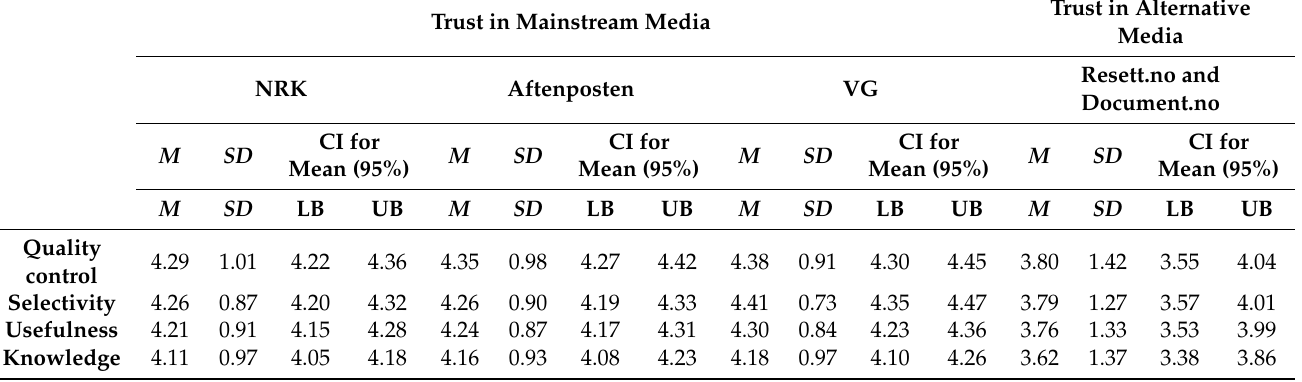
Table 3. Attitudes towards journalistic gatekeeper functions among people who trust mainstream news media compared with people who trust alternative news media. Trust in Mainstream Media